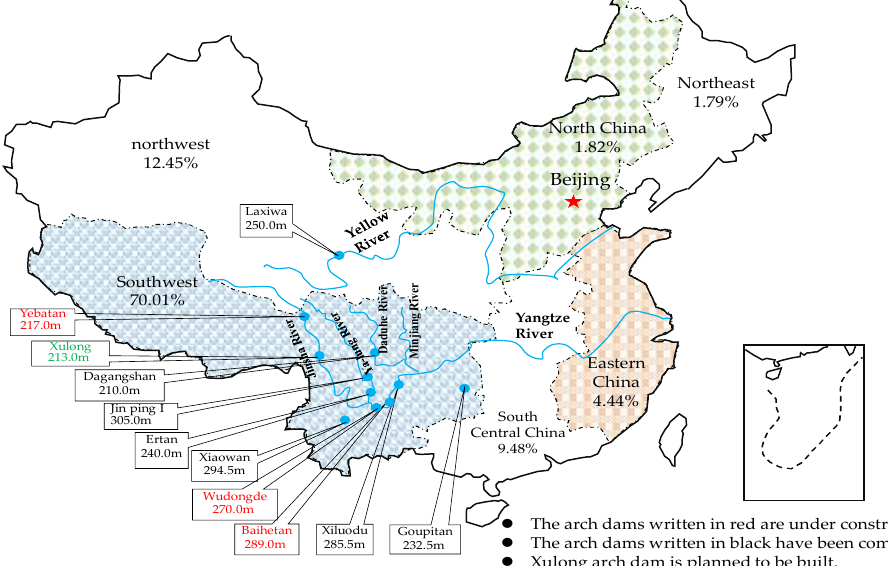
Figure 1. Distribution of hydropower resources and super-high arch dams in China.